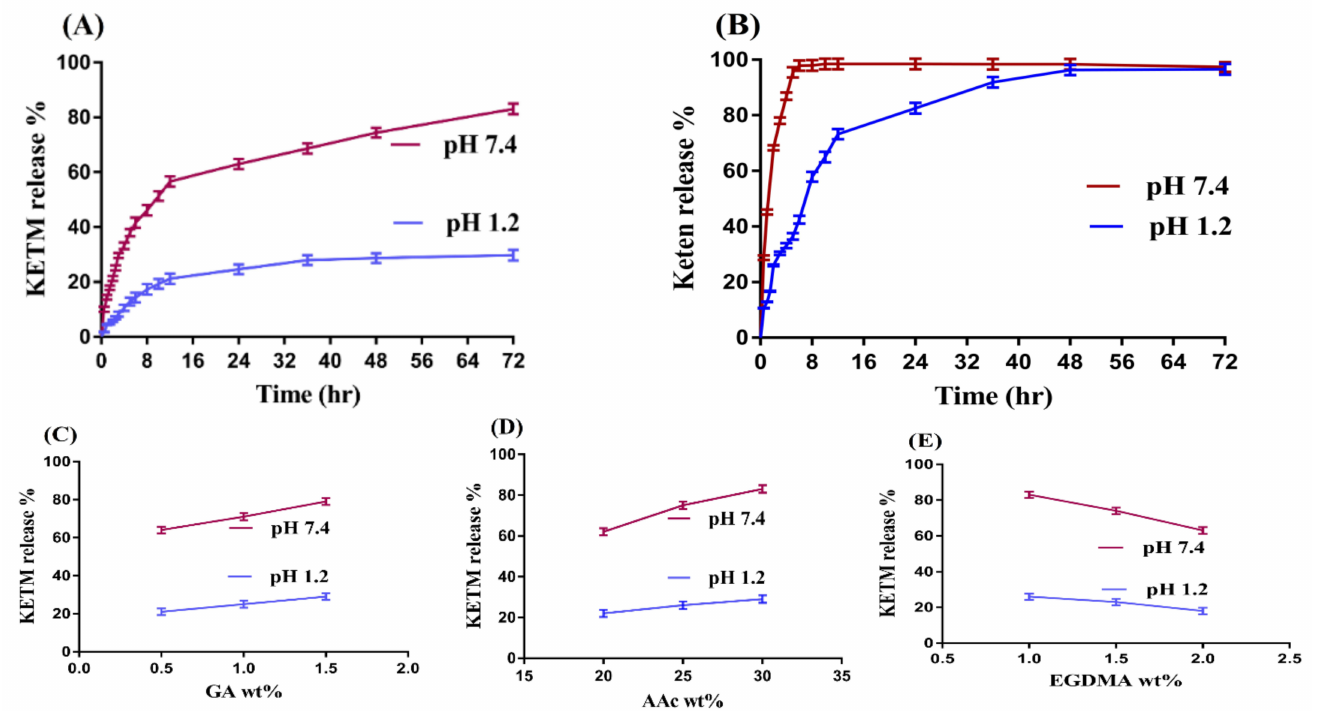
Figure 7. Effects of ( A ) pH, ( B ) commercial product Keten, ( C ) GA, ( D ) AAc, and ( E ) EGDMA on KETM percent release from GAcPAAc